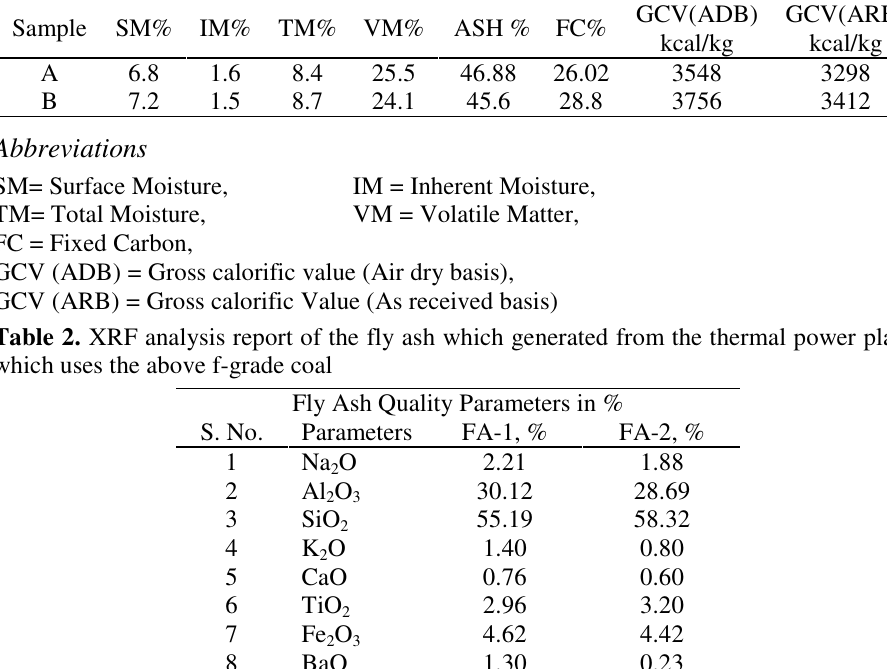
Table 1. The proximate analysis report of the F-grade coal collected from thermal power plants of Rajasthan